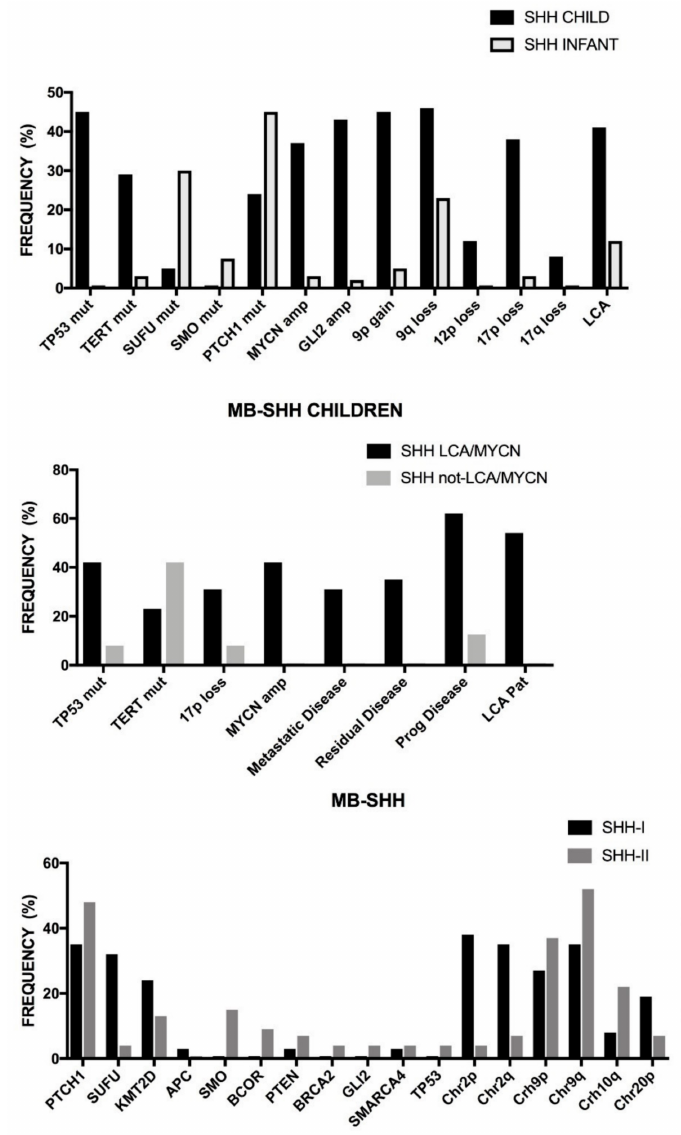
Figure 9. Clinical and biologic properties of SHH medulloblastomas. ( A ) Clinical and biologic properties of SHH medulloblastomas subdivided into SHH children and SHH infants according to the age of the patients. Data are reported in the study of Schwabe et al., 2017 [185]. ( B ) Clinical and biologic properties of SHH medulloblastomas observed in children, subdivided into two subgroups with high-risk (positivity for LCA histology and MYCN amplification) and with low-risk (negativity for LCA histology and MYCN amplification). Data are reported in the study of Schwabe et al., 2017 [185]. ( C ) Molecular properties of SHH medulloblastomas subdivided into SHH-I and SHH-II subgroups distinguished according to their methylation pattern according to the data reported by Robinson et al., 2017. [186]. MB: